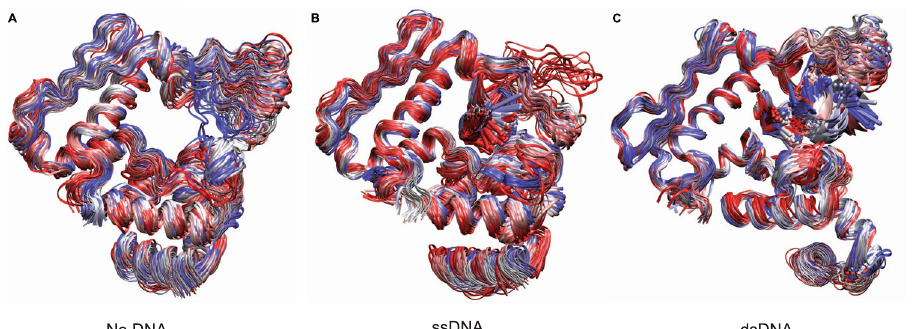
Fig. 6 | Molecular dynamics simulations of Red β 177 . The sampled ensemble of apo ( A ), ssDNA-bound ( B ) and dsDNA-bound ( C ) states used in the molecular dynamics simulations. Trimeric systems with weak harmonic positional restraints onthebackboneatomsoftwooutsideproteinchainsandDNAweresimulated.One